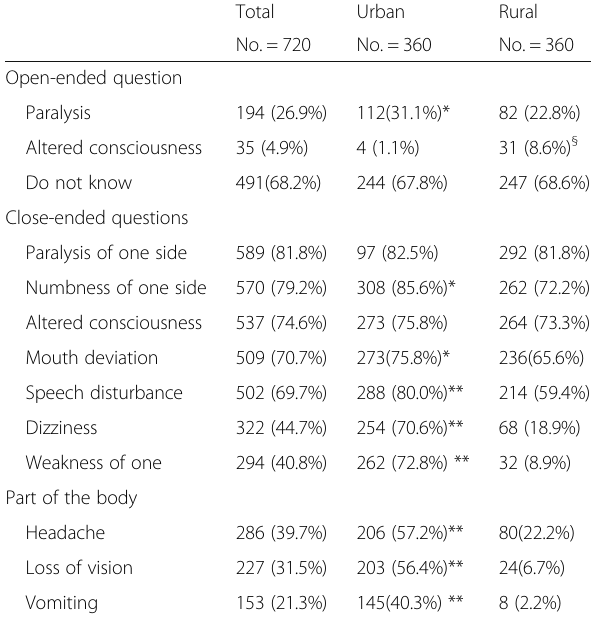
Table 4 Knowledge of the warning symptoms of cerebro-